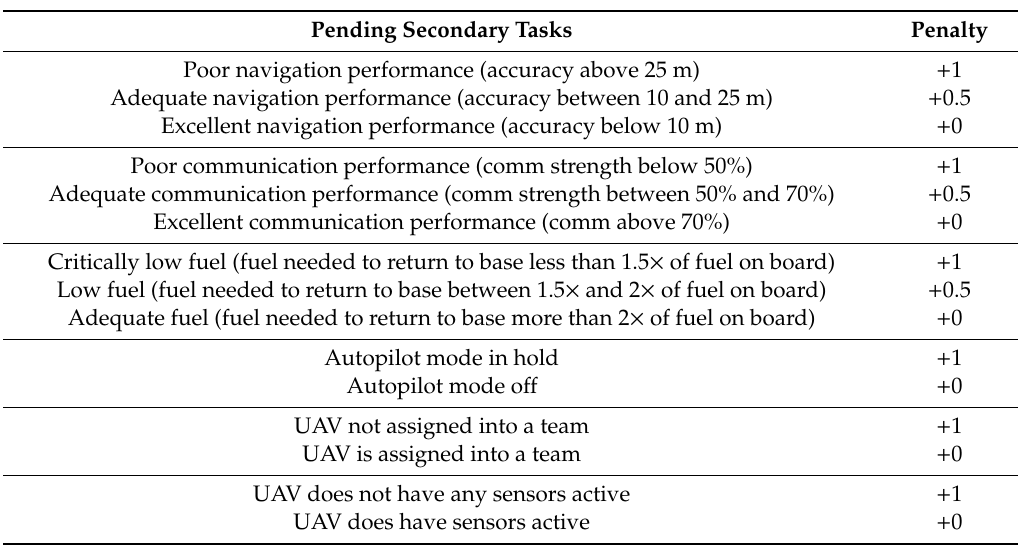
Table 2. Task index calculation for each